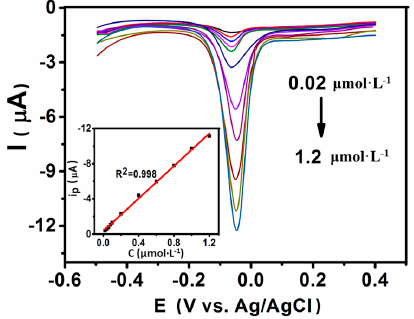
Figure 6. DPASV of the RGO/CMC/Nafion modified GCE in 0.1 M NaAc–HAc (pH = 4.4) with various concentrations of Cu(II). From top to bottom, the different colors of the curves represent the concentration of Cu(II) of 0.02, 0.04, 0.06, 0.08, 0.1, 0.2, 0.4, 0.6, 0.8, 1.0 and 1.2 μ mol·L − 1 , respectively. Inset is the calibration curve of the stripping peak currents versus the concentrations of Cu(II).